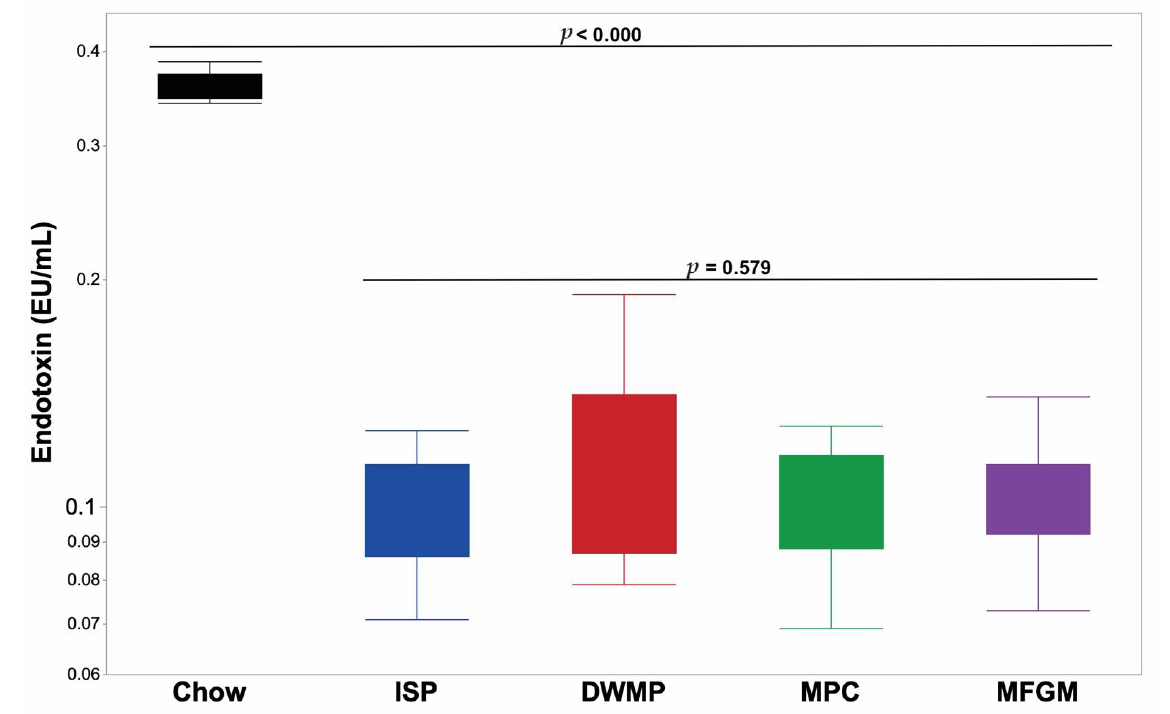
Figure 6. Plasma endotoxin concentrations of chow-fed vs. purified diet-fed mice. Plasma endotoxin content, measured by the limulus amebocyte lysate (LAL) assay, averaged 0.352 ± 0.011 EU/mL for chow-fed mice ( n = 10) compared to average 0.109 ± 0.004 EU/mL for purified diet-fed mice ( n = 60). Chow-fed mice showed a 322% increase in plasma compared to the average of purified diet-fed mice.